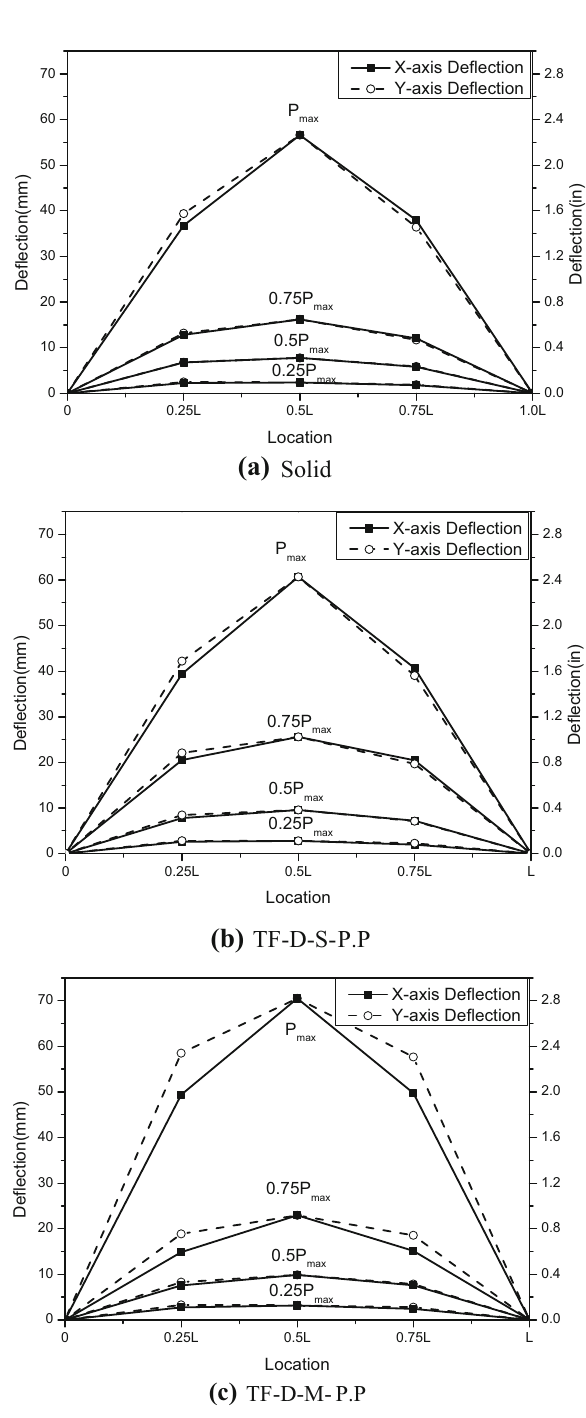
Fig. 12 Deflection distributions of two-way slab specimens.